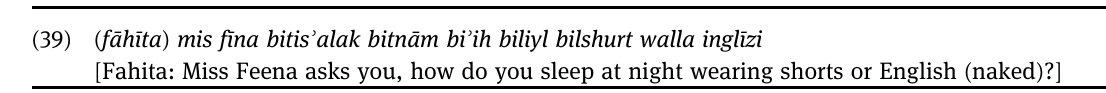
[ Fahita: Miss Feena asks you, how do you sleep at night wearing shorts or English ( naked ) ? ] The description provided in Example ( 40 ) of the fan sending this question is incredibly humorous: a 52 - year - old virgin running a prostitution network. Even Maged notices the humorous combination and asks Fahita to con fi rm whether the lady concerned is a virgin. Additionally, as running a prostitution network is a criminal act in Egypt, this makes it impossible that any woman involved in such a business would simply confess it. The question itself concerns Maged ’ s sexual preferences in women.